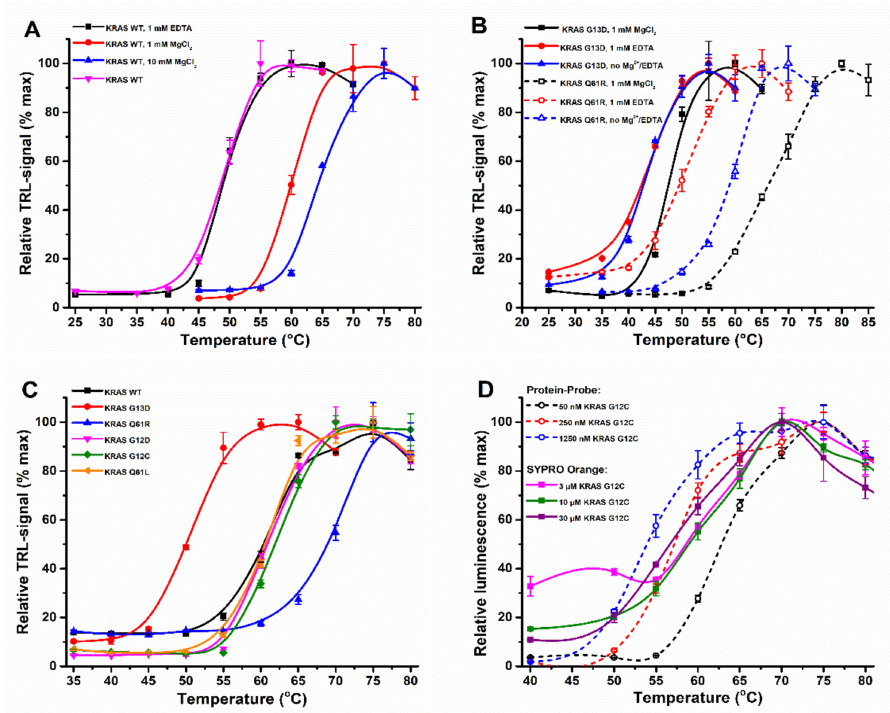
Figure 1. Buffer, mutational status, and concentration effects on KRAS thermal stability. ( A ) KRAS WT (100 nM) showed clear MgCl 2 -dependent thermal stabilization when assayed using the Protein- Probe. The presence of 1 (red) or 10 mM (blue) MgCl 2 increased KRAS WT thermal stability by approximately 10 ◦ C over that without MgCl 2 (black) and with additional 1 mM EDTA (magenta). ( B ) KRAS (100 nM) mutational status affects the MgCl 2 dependence. KRAS G13D (solid line) and Q61R (dashed line) responded differently in the absence of MgCl 2 (blue) or presence of 1 mM MgCl 2 (black) or 1 mM EDTA (red). While KRAS G13D is thermally unstable in all conditions, Q61R showed significantly compromised stability in the presence of 1 mM EDTA. ( C ) KRAS (50 nM) thermal stability is dependent on its mutational status. From the hotspot KRAS mutants tested, G13D (red) and Q61R (blue) significantly differ from the other tested KRAS proteins: WT (black), G12D (magenta), G12C (green), and Q61L (orange). ( D ) Increase in KRAS G12C concentration decreased its stability in Protein-Probe (dashed line) and SYPRO Orange (solid line) assays. Using the Protein-Probe, a significant decrease in KRAS G12C thermal stability was obtained when protein concentration was increased from 50 nM (black) to 250 nM (red) or 1250 nM (blue). Using the SYPRO Orange, the decrease in KRAS G12C T m was less pronounced at the assayed concentrations of 3 µ M (magenta), 10 µ M (green) or 30 µ M (violet). Data represent mean ± SD ( n =